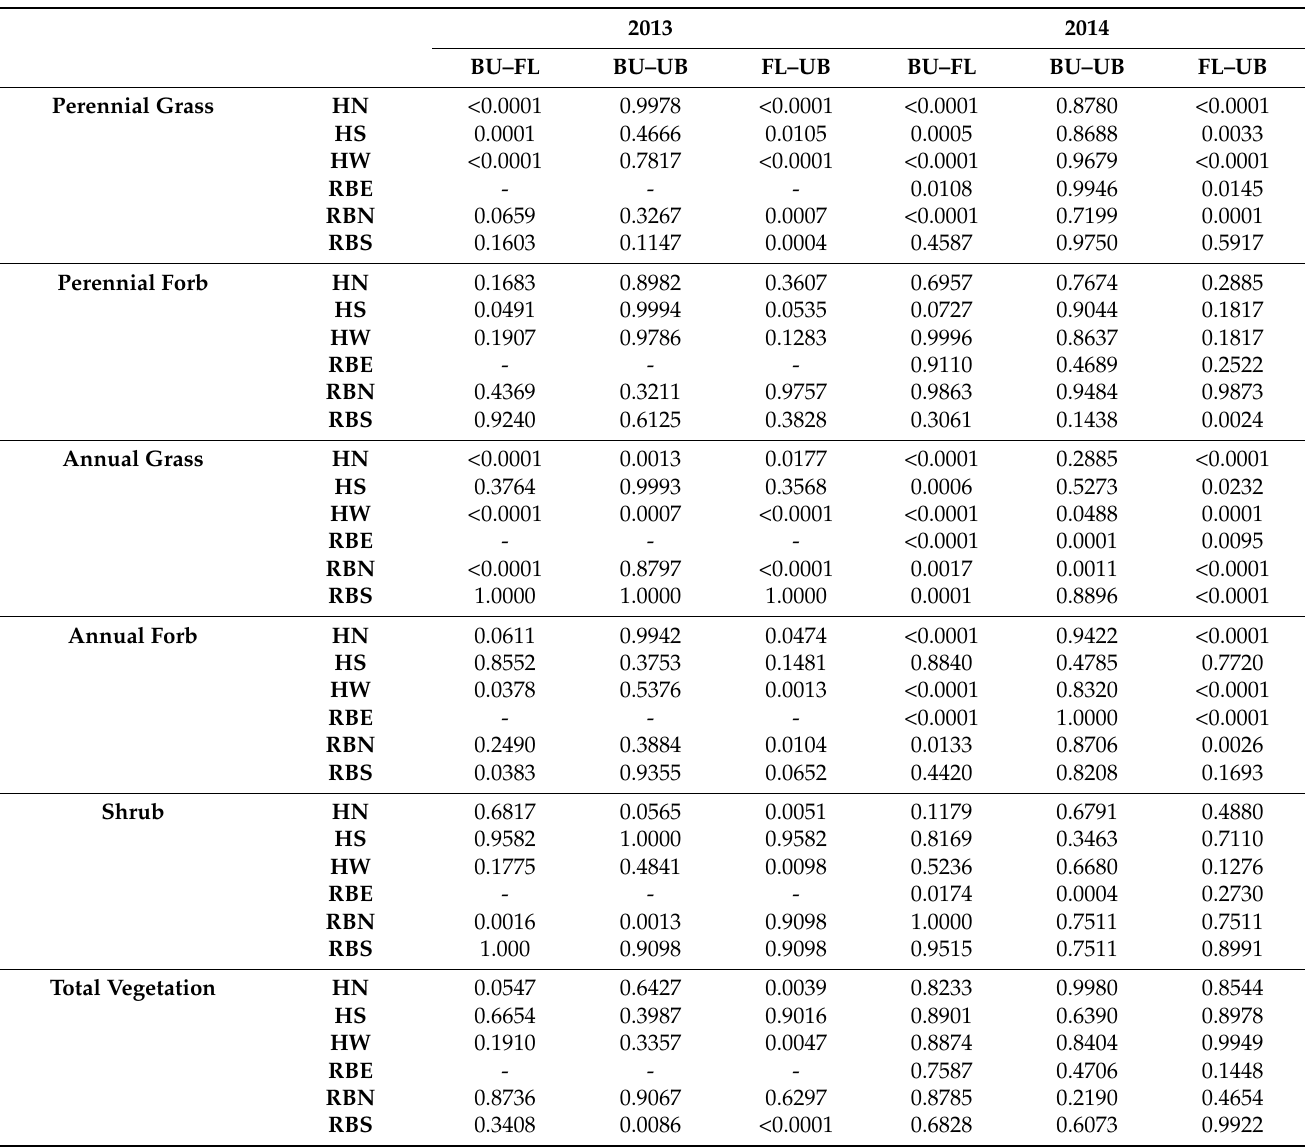
Table 2. P-values from pairwise comparisons among treatments within sites for the responses of perennial grass, perennial forb, annual grass, annual forb, shrub, and total vegetation. Sites are HN, HS, HW, RBE, RBN, and RBS, while treatments are burned (BU), unburned (UB), and fire line